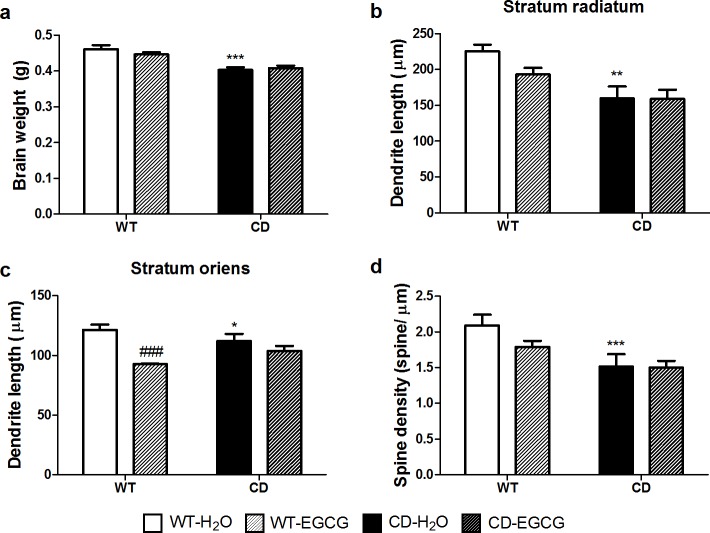
EGCG does not influence brain abnormalities present in CD mice.(a) Brain weight of water or EGCG fed CD mice was significantly reduced when compared to WT mice. A two-way ANOVA indicated a significant effect of genotype (F1,37 = 40.72, p<0.0001) but no effect of treatment (F1,37 = 0.3766, p = 0.5432). (b) Dendrite length of CA1 neurons was measured in stratum radiatum (SR). A two-way ANOVA indicated a significant effect of genotype (F1,37 = 15.98, p = 0.0003) but not effect of treatment (F1,37 = 1.728, p = 0.1968) (c) Dendrite length of CA1 neurons was measured in stratum oriens (SO). A two-way ANOVA indicated a deleterious effect of treatment in the case of WT mice (F1,37 = 22.92, p<0.0001 with p<0.001 Bonferroni post hoc test). (d) EGCG treatment did not increase the number of spines present in apical dendrites of CD neurons. A two-way ANOVA indicated a significant effect of genotype (F1,37 = 13.13, p = 0.0009) without treatment effect (F1,37 = 1.722, p = 0.1976). n = 8–13 mice per group. p values are shown with asterisks (genotype) or hashes (treatment) indicating values that are significantly different (two-way ANOVA with Bonferroni post hoc test). *,#p<0.05; **,##p<0.01; ***,###p<0.001. White, WT; Black, CD. Plain, water; Striped, EGCG fed mice. Data are presented as the mean ± SEM.